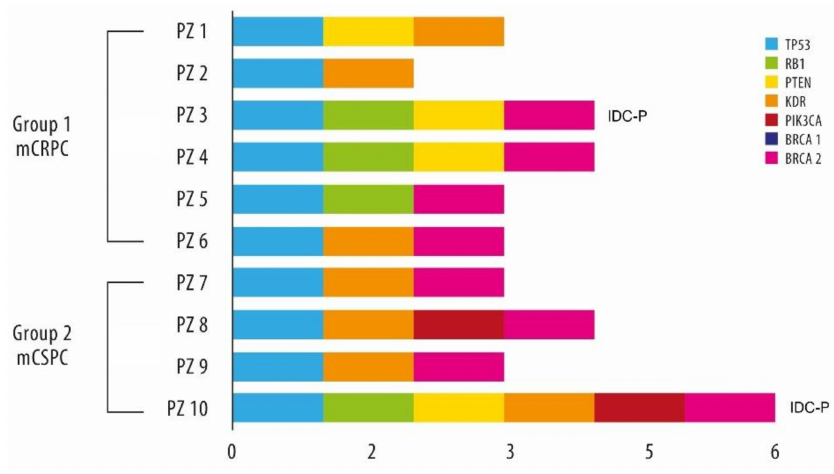
Figure 2. Patterns of mutation in the 10 patients with exploratory NGS data. IDC-P = intraductal carcinoma of